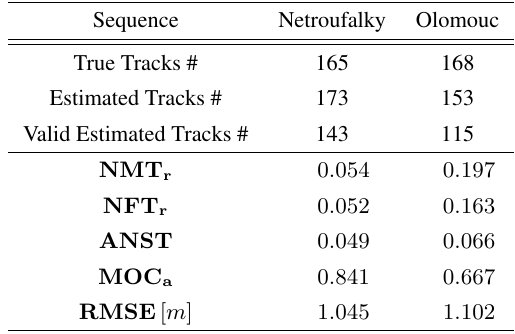
Table 1. The results of the evaluation.